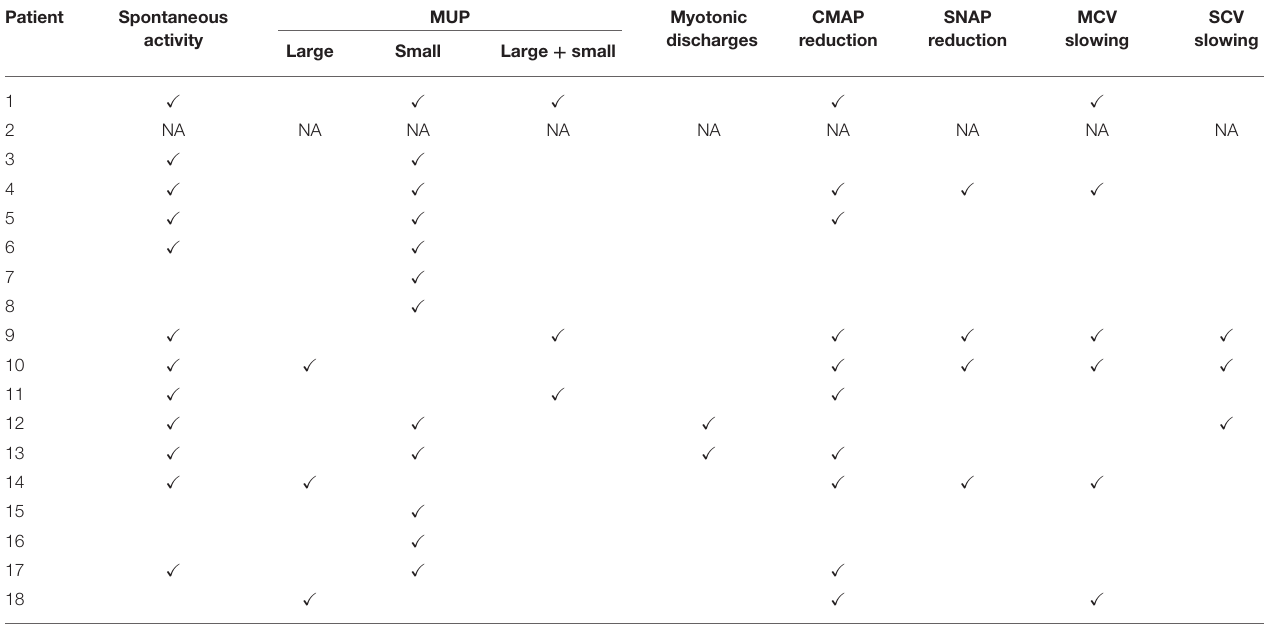
TABLE 3 | Electromyographic features of the present MFM patient cohort. Patient Spontaneous